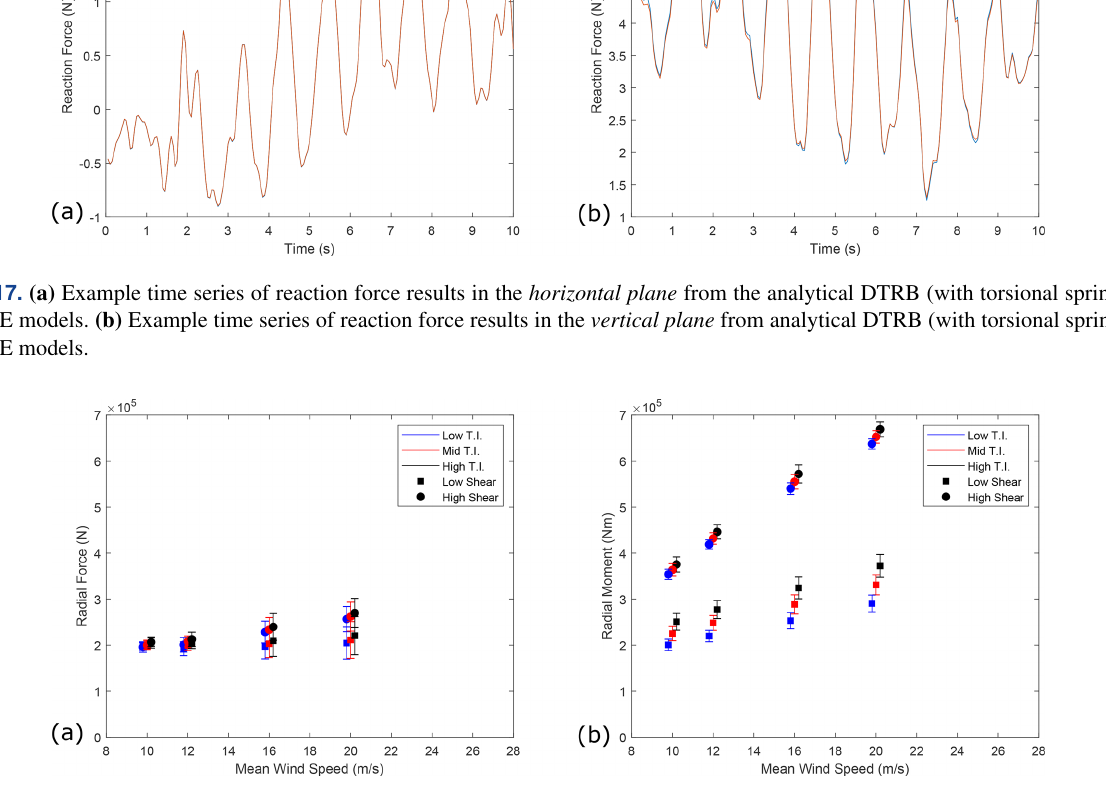
Figure 18. (a) Mean radial resultant force magnitudes from the analytical DTRB model. Mean and standard deviations within each CPLS are plotted, staggered about mean wind speeds for clarity. (b) Mean resultant moment magnitudes from the analytical DTRB model. Mean and standard deviations within each CPLS are plotted, staggered about mean wind speeds for